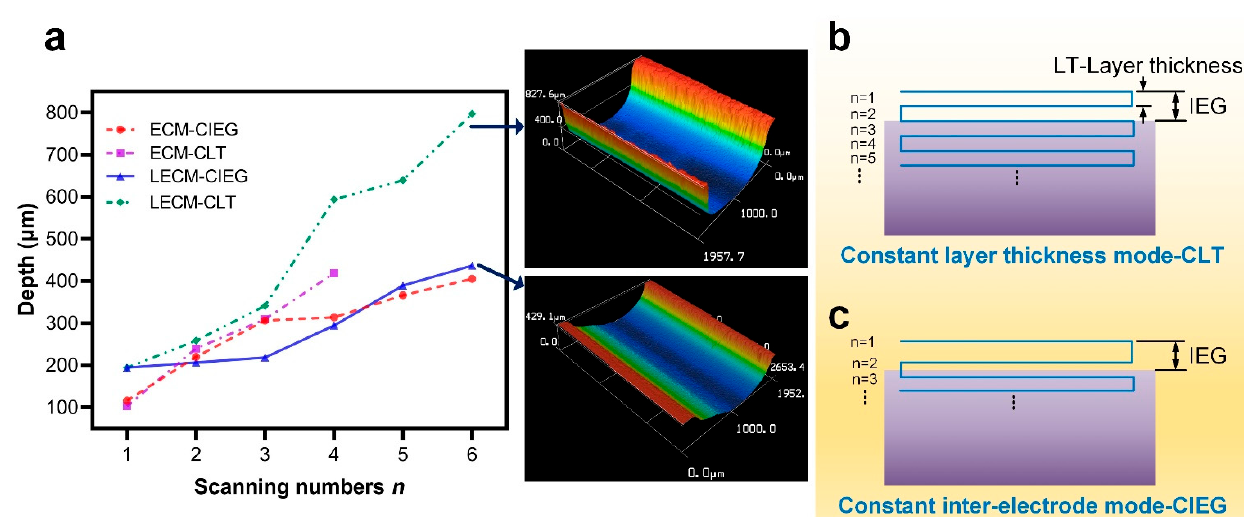
Figure 10. ( a ) Variation of the depth of the microgrooves processed by layer-by-layer Laser-STEM utilizing: ( b ) the constant layer thickness mode (CLT), and ( c ) the constant inter-electrode mode (CIEG).